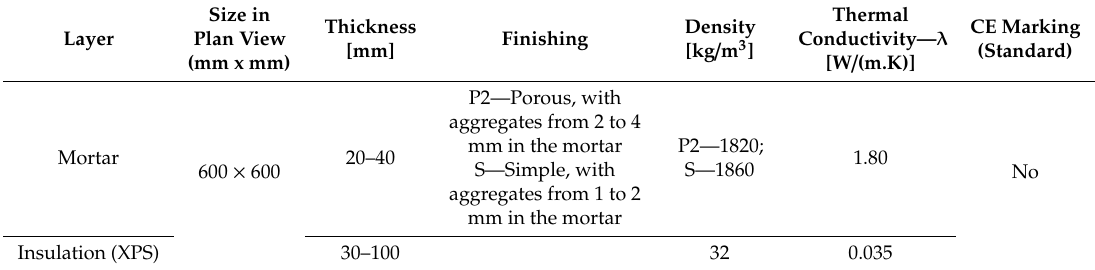
Table 1. Most relevant technical characteristics of the thermal insulation tiles for flat roofs